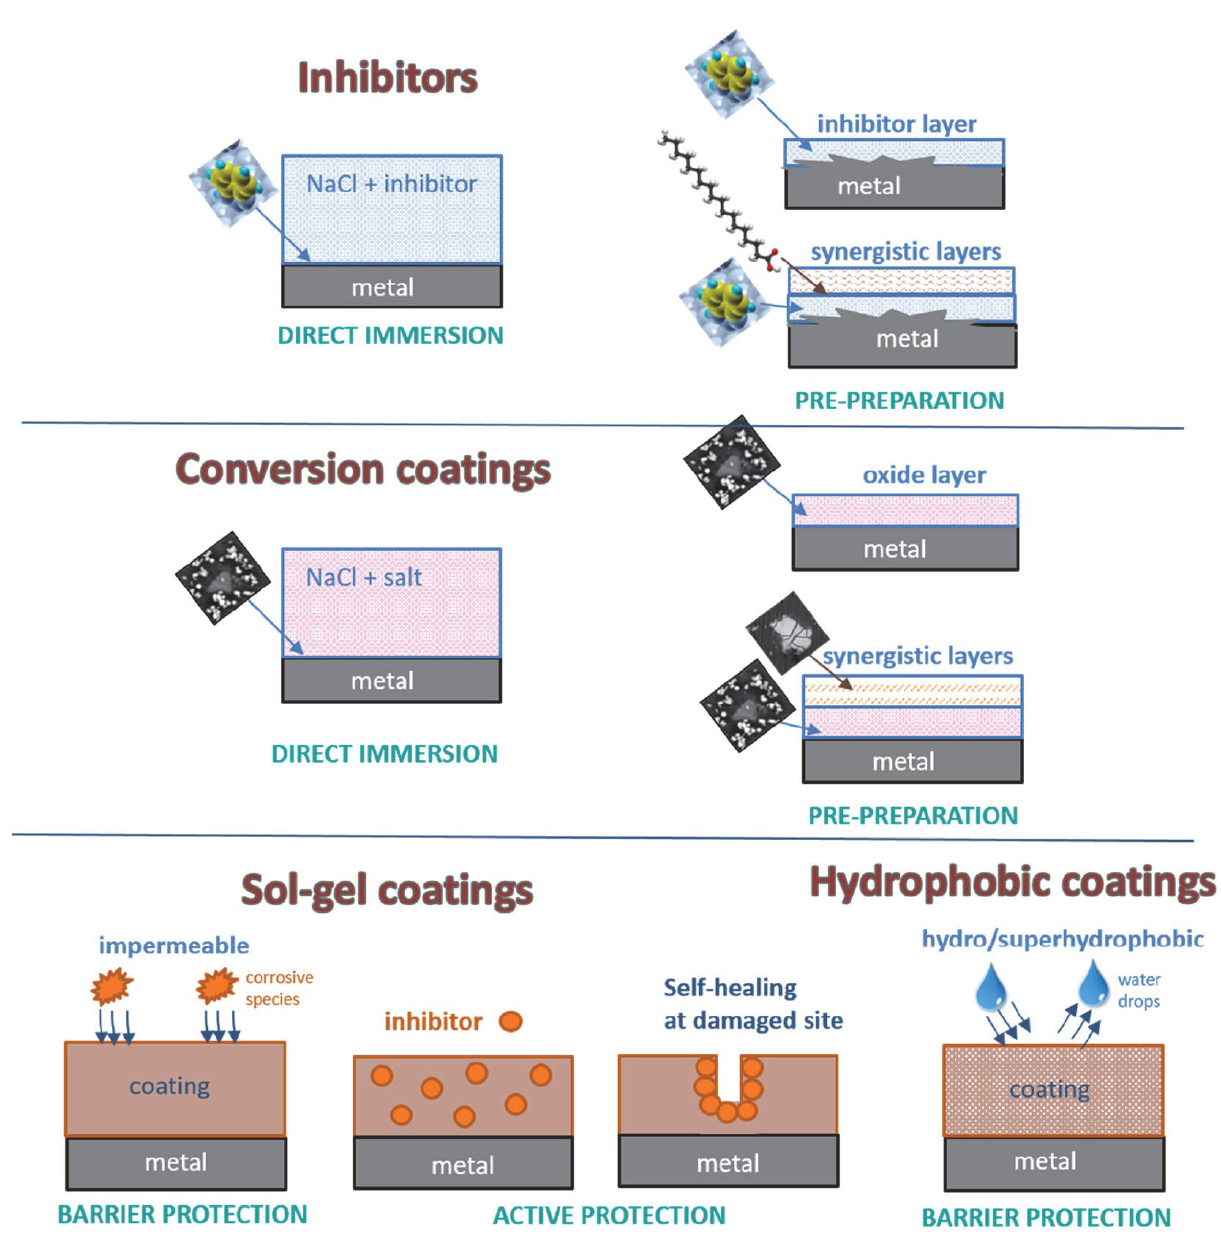
Figure 4. Modifications of metal surfaces using various